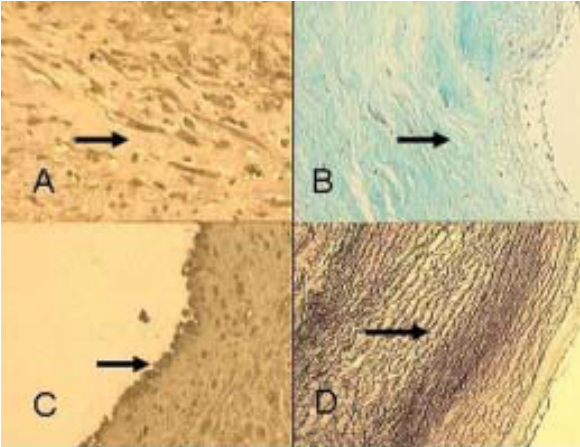
Fig. 3 - Análise histológica por microscopia ótica dos enxertos criopreservados. Fotomicrografias de corte histológico de conduto pulmonar, heteroenxerto descelularizado, aumento 40x. A: imunohistoquímica para Vimentina, observa-se presença de células com características de fibroblastos. B: coloração de Gomori demonstra fibras colágenas íntegras. C: imunohistoquímica para fator VIII, evidenciando-se células endoteliais. D: coloração de Weigert, observa-se a presença de fibras elásticas íntegras